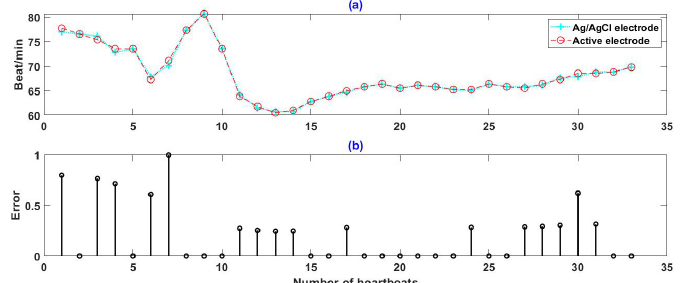
Figure 7. Comparison between instantaneous heart rate obtained by active electrode and Ag/AgCl electrode: ( a ) instantaneous heart rate, ( b ) the error between instantaneous heart rate obtained by two kinds of